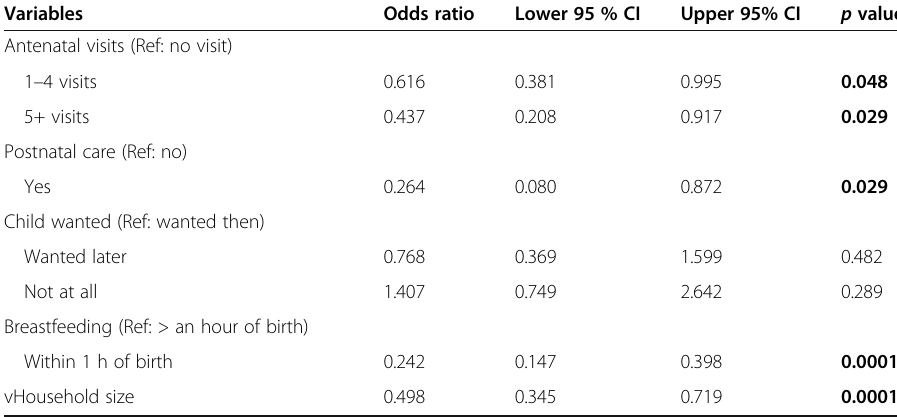
Table 3 Logistic regression analysis of under-five mortality in Ethiopia (Continued) Variables Odds ratio Lower 95 % CI Upper 95%